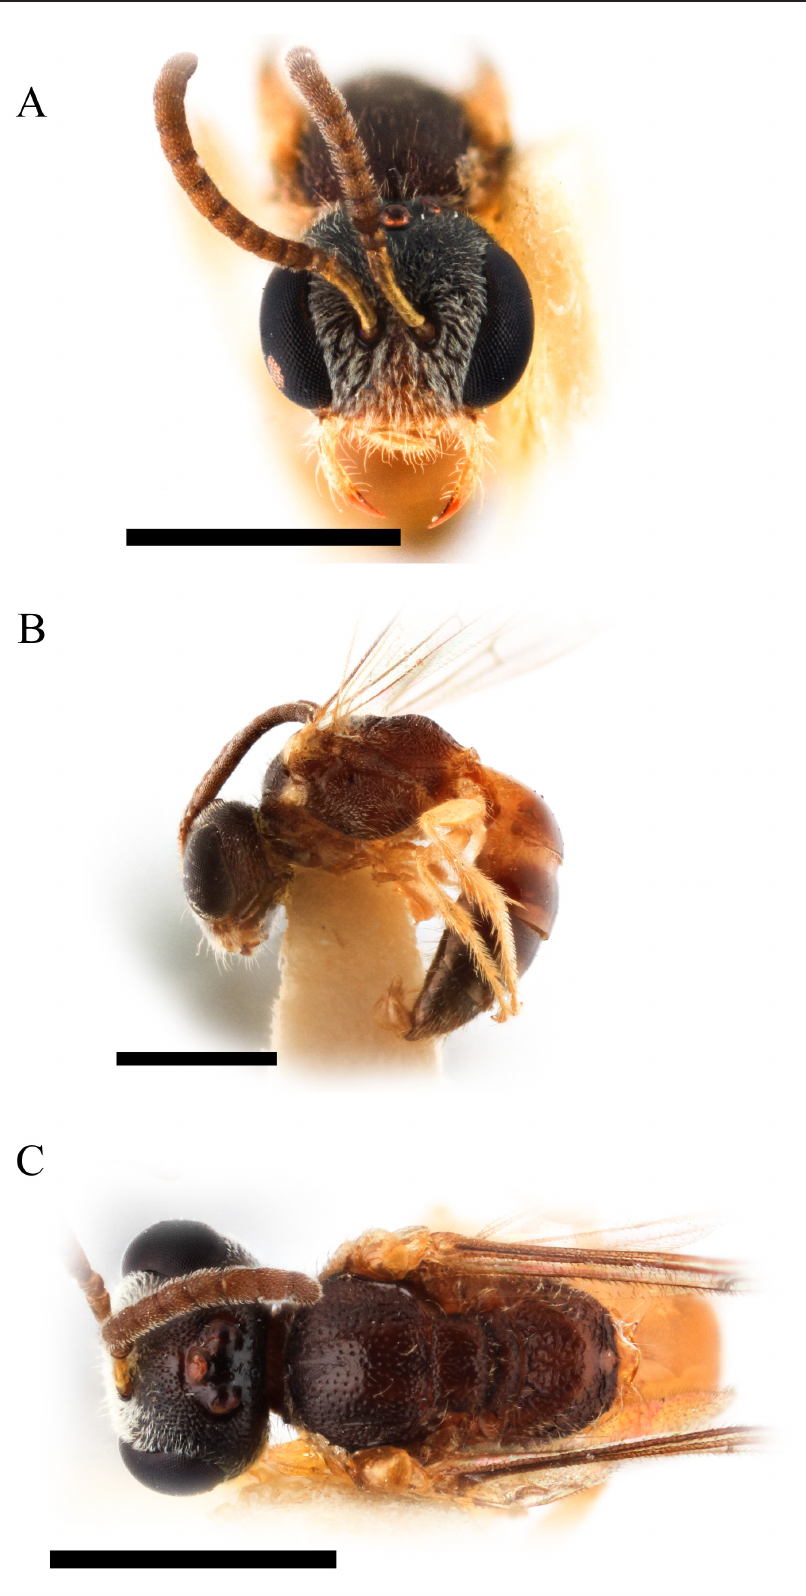
Fig. 16. Microsphecodes dominicanus (Stage, 1972). Paratype, ♂. A . Face. B . Lateral habitus. C . Dorsum of mesosoma. Scale bars = 1